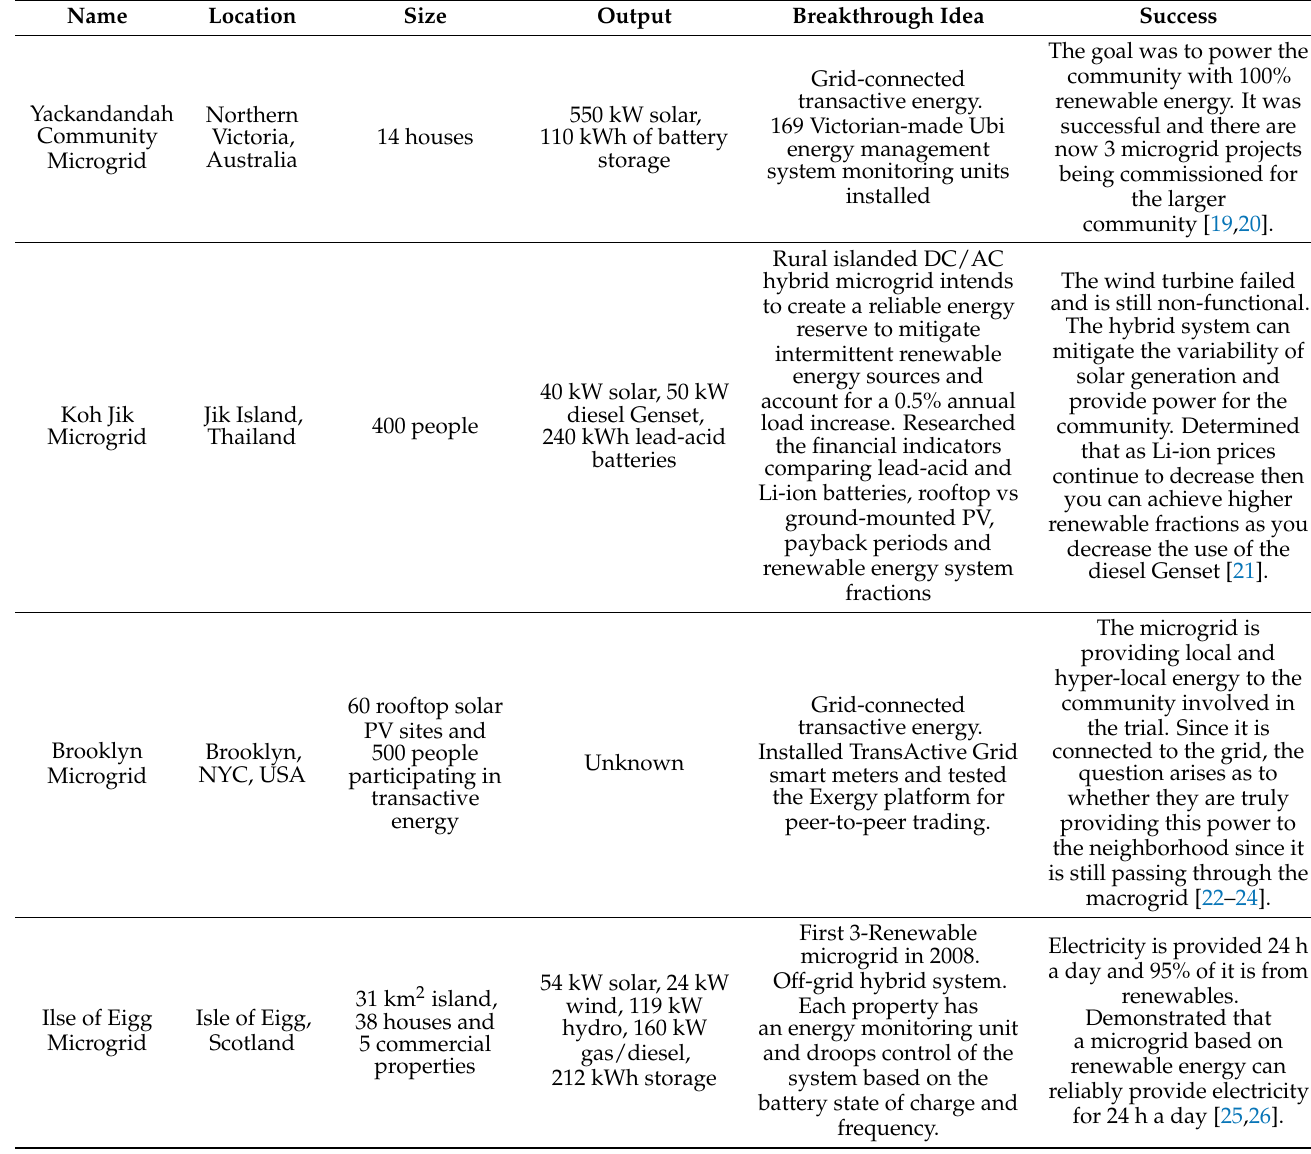
Table 1. Highlights of deployed microgrids with breakthrough